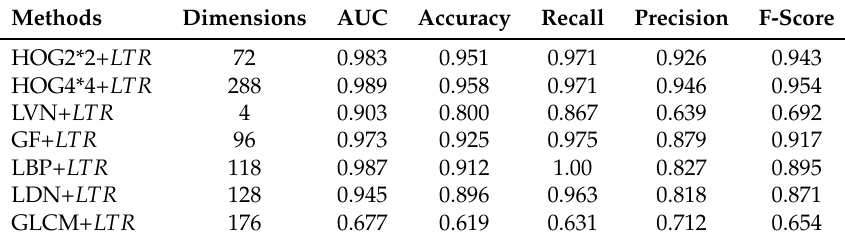
Table 6. The performance of the proposed method when concatenating the representations learned by the forward and backward LTR.